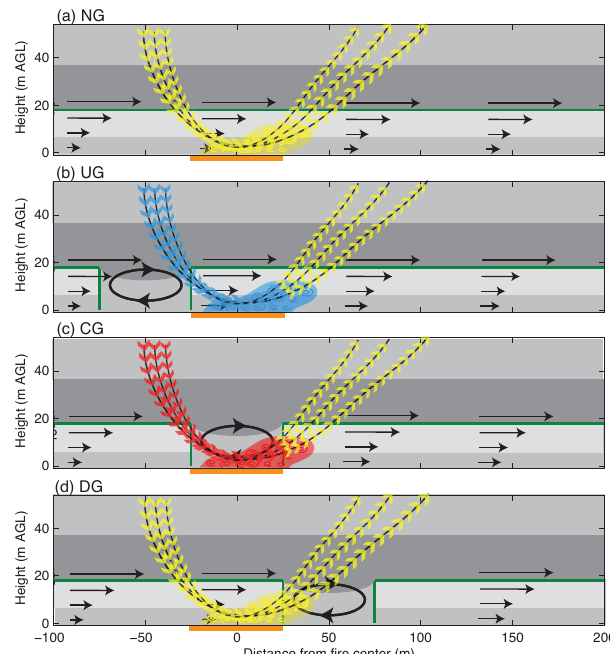
Figure 12. Conceptual model of fire–atmosphere interactions with different forest gap configurations. Background (i.e., no fire) state indicated with black arrows and grayscale shading: black hori- zontal arrows indicate the background mean u component of the wind, black oval inside gap represents the gap recirculation zone, and shading indicates background mean TKE (light (weakest) → dark (strongest)). Fire anomaly fields are depicted with colored ar- rows and shading: selected fire-line-normal streamlines are indi- cated with colored arrows, and region of enhanced TKE and tur- bulent mixing of heat is represented by semi-transparent shading and embedded spirals. The magnitude of the fire anomaly is indi- cated by the color (blue (weakest) → yellow → red (strongest)). As in Figs. 2–7, the fire zone is denoted with an orange line, and the perimeter of the forest canopy is indicated with a green